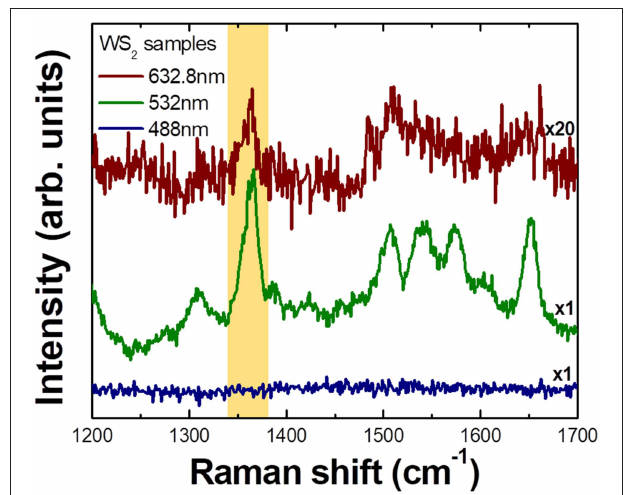
FIGURE 3 | Wavelength dependent Raman spectra of R6G molecules adsorbed on CVD grown WS 2 nanoflower substrate measured with 3 different excitation lasers. Phonon intensity in each spectrum is normalized to Si phonon (520 cm − 1 ) intensity. The largest enhancement is observed at 532.0nm excitation and significantly weaker but observable enhancement is observed at 632.8nm excitation. No observable enhancement is seen under 488.0nm